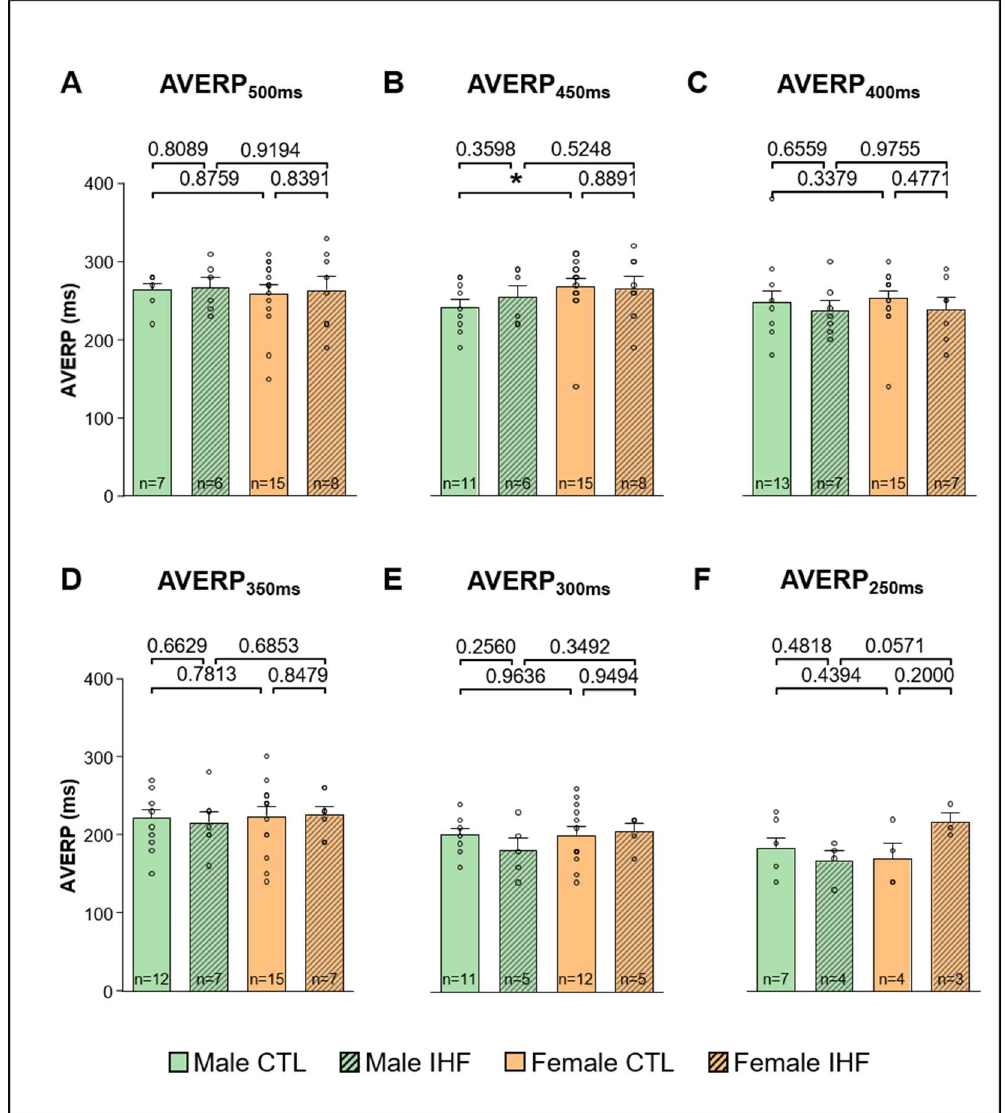
Figure 7. Atrioventricular Effective Refractory Period (AVERP). ( A ), AVERP at a basic cycle length of 500 ms. ( B ), AVERP at a basic cycle length of 450 ms. ( C ), AVERP at a basic cycle length of 400 ms. ( D ), AVERP at a basic cycle length of 350 ms. ( E ), AVERP at a basic cycle length of 300 ms. ( F ), AVERP at a basic cycle length of 250 ms. CTL , control animals without ischemic heart failure; IHF , animals with ischemic heart failure. Bar graphs represent Mean + SEM, grey circles represent data of individual pigs. Mann-Whitney-U Test. * p < 0.05.